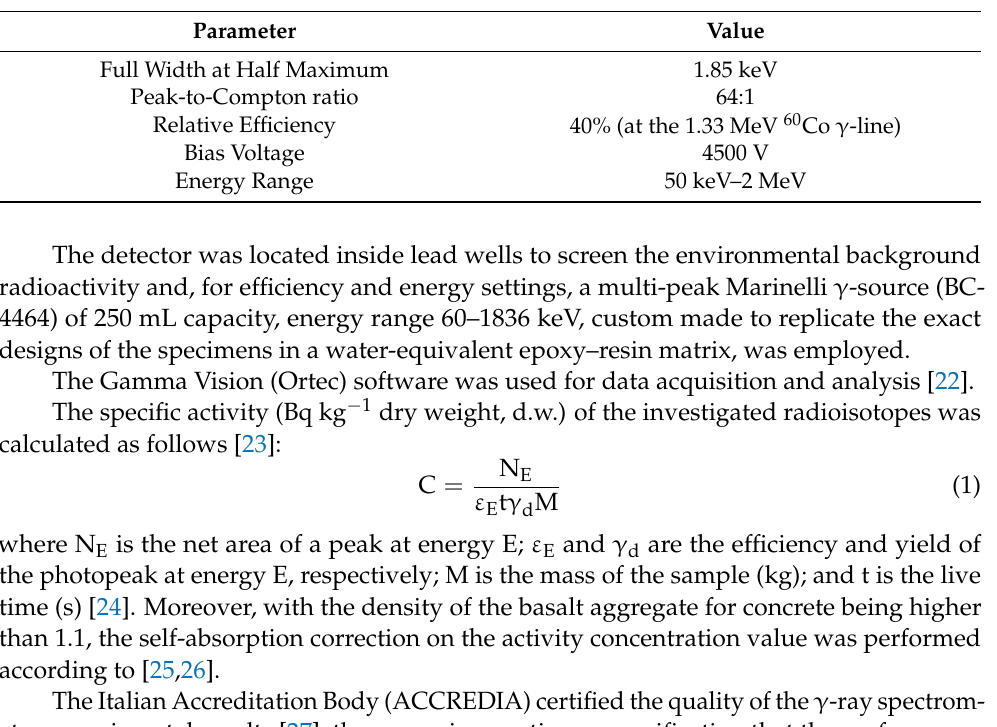
Table 1. The HPGe GEM operating parameters. HPGe GEM Parameter Value Full Width at Half Maximum 1.85 keV Peak-to-Compton ratio 64:1 Relative Efficiency 40% (at the 1.33 MeV 60 Co γ -line) Bias Voltage 4500 V Energy Range 50 keV–2